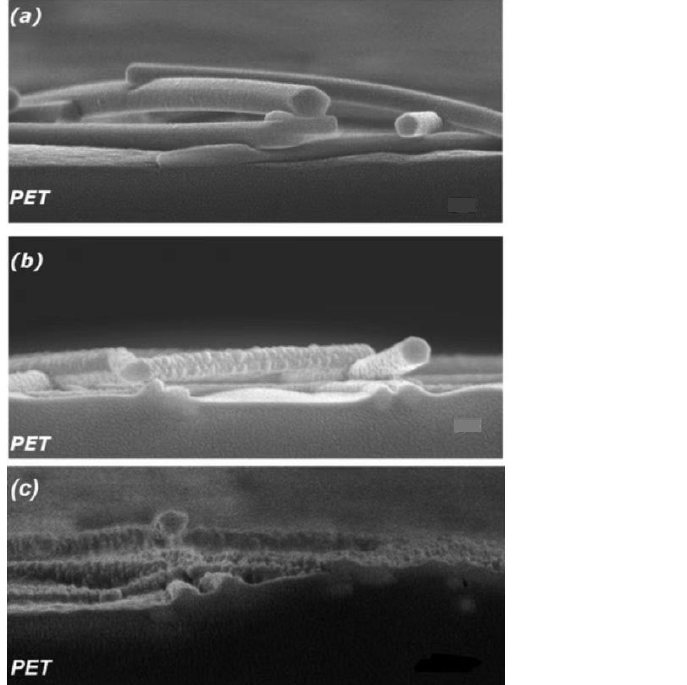
Figure 7. Cross-sectional SEM images of AgNW films on PET substrates ( a ) before and ( b , c ) after HIPL sintering with light intensities of 11,400 J/m 2 and 23,300 J/m 2 , respectively. Reprinted with permission from [89]. Copyright 2012 Royal Society of